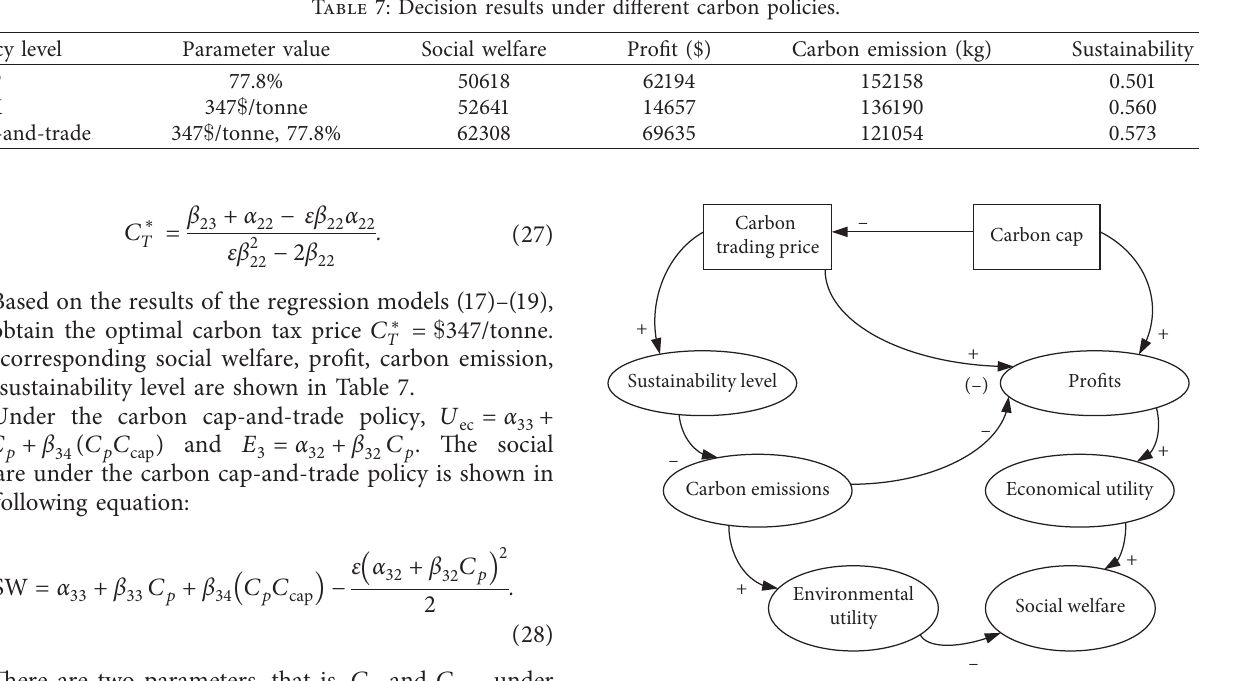
Figure 2: Causal relationships under cap-and-trade